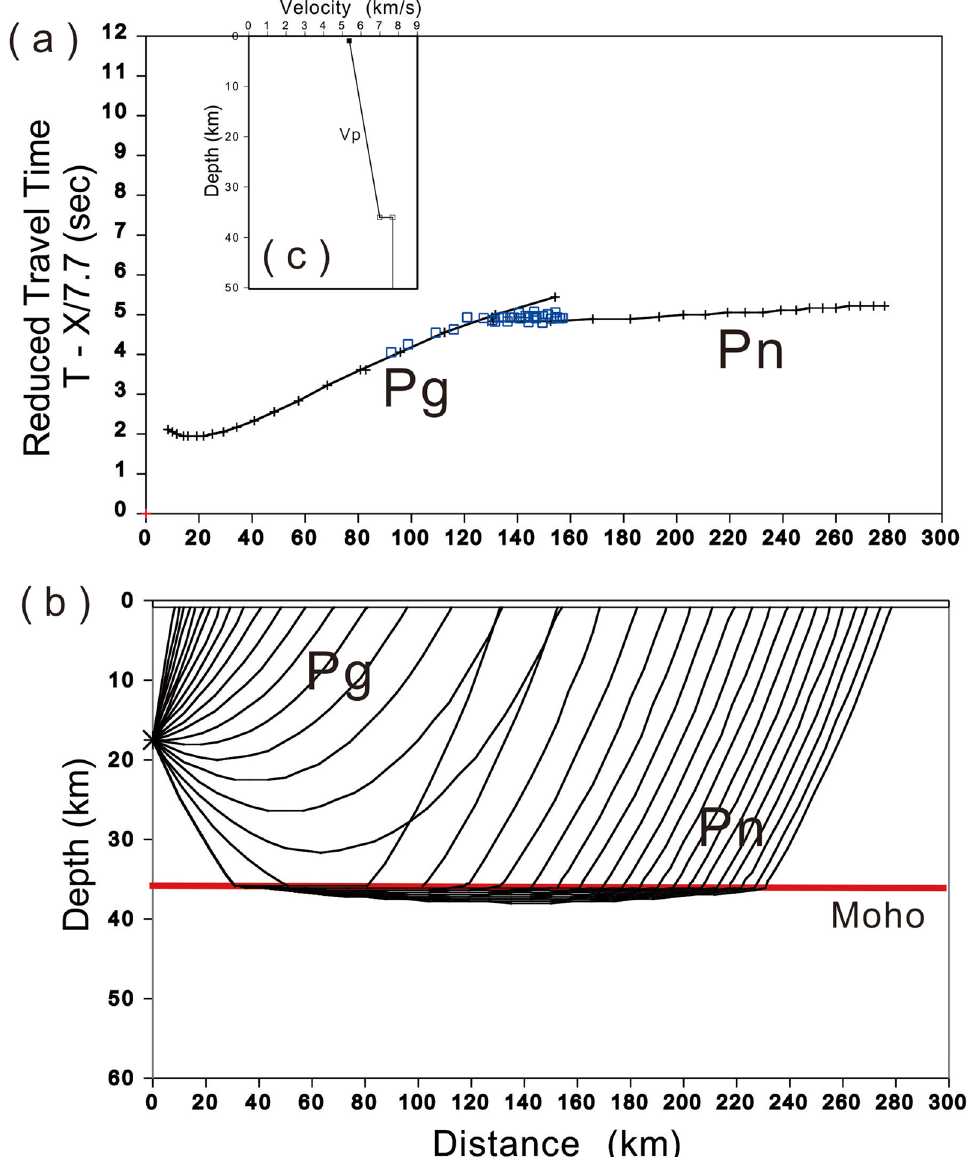
Fig. 9 a Comparison of observed (small squares) and calculated (lines with pluses) P wave arrivals for Events 1 or 2. b The ray paths of the direct (Pg) and refracted (Pn) P‑waves from the Moho‑discontinuity. c The one‑dimensional velocity model for calculating P wave travel